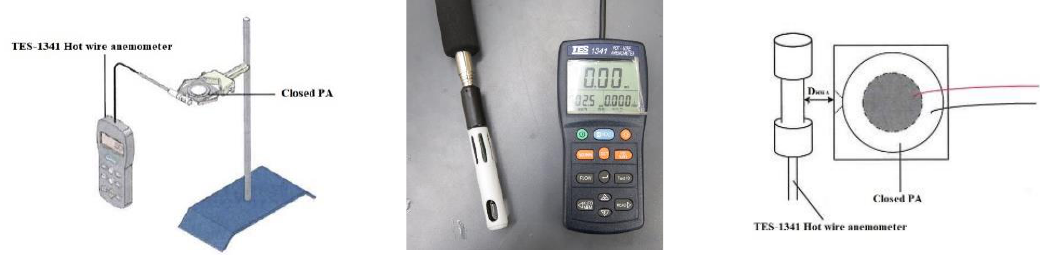
Figure 7. Hot wire anemometer.